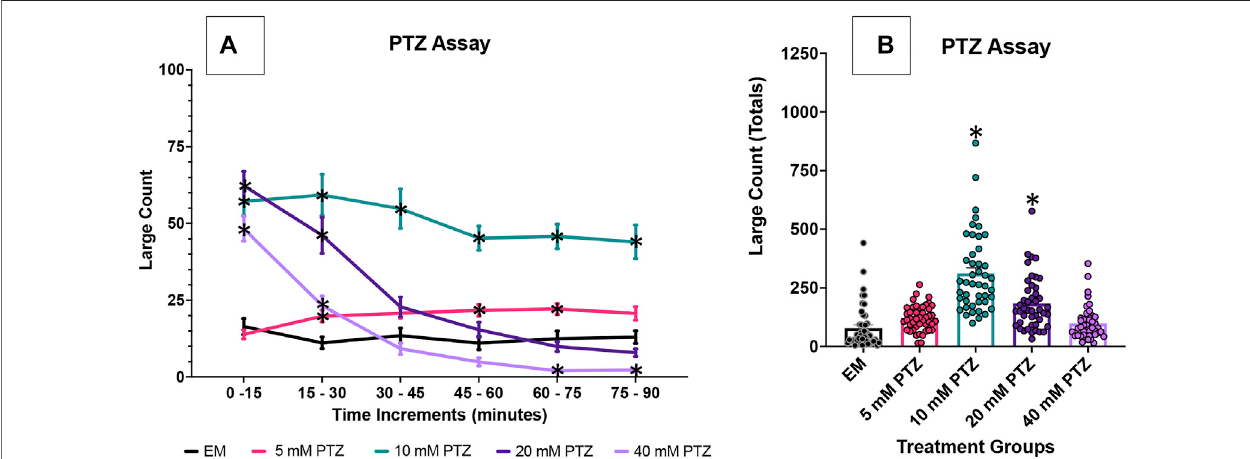
FIGURE 1 | Behavioral pro fi le of zebra fi sh larvae exposed to PTZ. The following graphs displays the average large count ( y -axis) of larvae. (A) The average larval large count is depicted per 15 min interval ( x -axis) of the tracking session. Zebra fi sh larvae were tested PTZ concentrations at 5 mM, 10 mM, 20 mM, and 40 mM (n = 70 fi sh/solution/concentration). Embryo medium (EM) was used as the control. Signi fi cance indicated by * p < 0.05 PTZ vs. EM, two-way ANOVA, Tukey ’ s post- hoc. (B) The total large count ( y -axis) over 90 min is displayed. The respective treatment groups ( x -axis). Analyses (one-way ANOVA, Tukey ’ s post-hoc) are marked * ( p < 0.05) to indicate signi fi cant differences to embryo medium